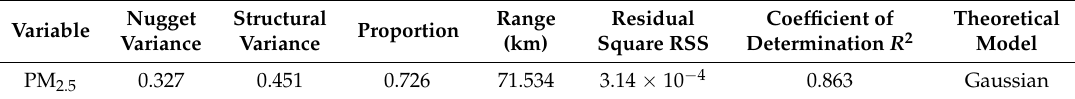
Table 2. Theoretic model and parameters of semivariance of PM 2.5 concentration in Chinese